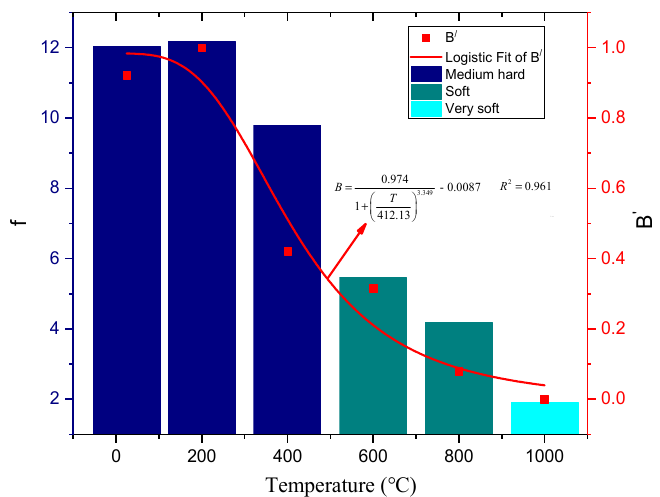
Figure 8. Proctor coefficient and normalized brittleness index of rock with temperature.